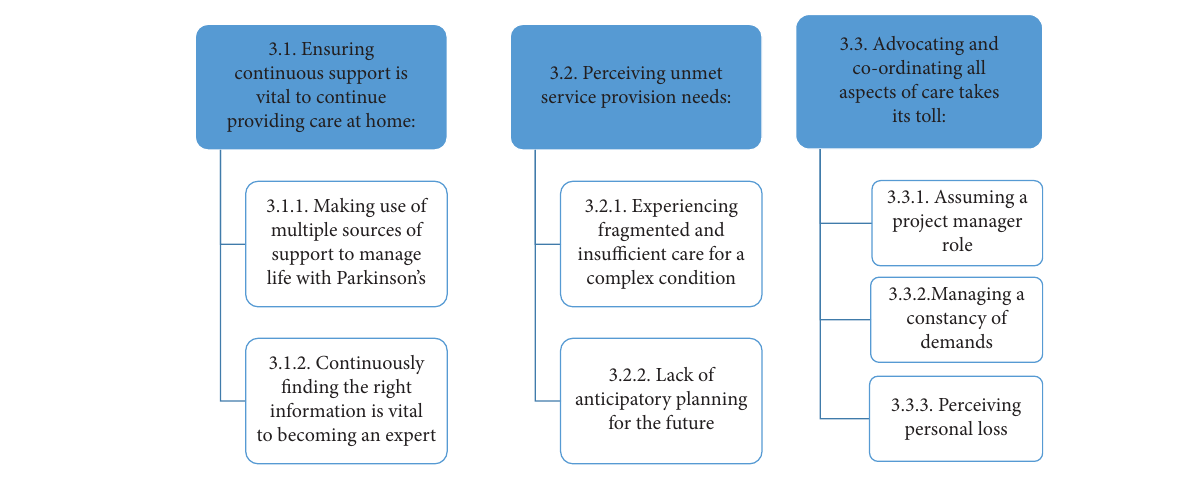
Table 3: Family-caregiver